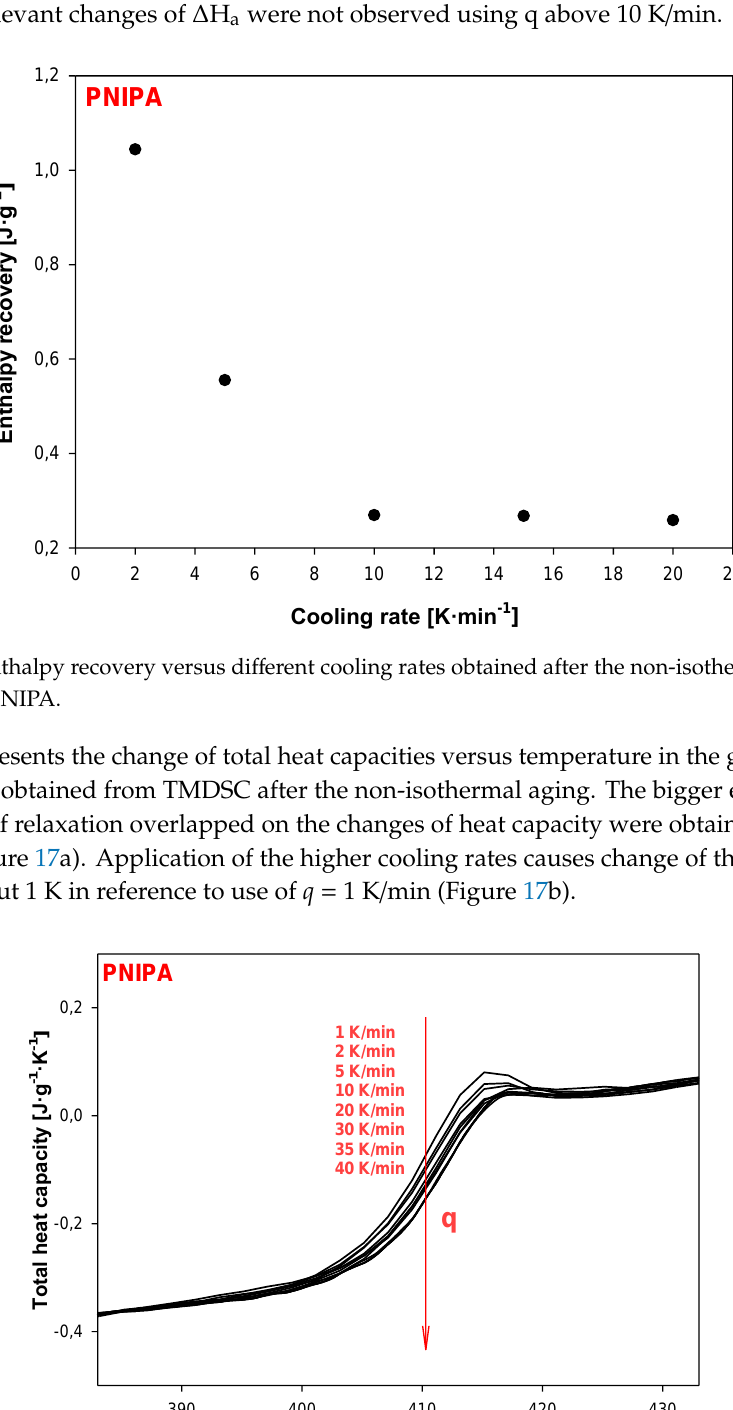
12 of 18 Figure 14. The dependence of heat flow rate on temperature obtained after the non-isothermal aging of PNIPA with a different cooling rate in the range of 2 K/min to 20 K/min. Similar to the isothermal physical aging, the enthalpy recoveries for the non-isothermal aging process were estimated. Results are presented in Table 3. Table 3. The enthalpy recovery (∆H a ) of PNIPA versus the different thermal history, cooling rate (q). Cooling Rate, Q [K/Min]